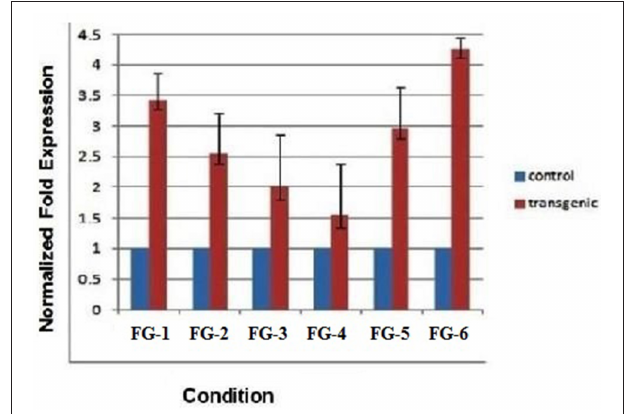
FIGURE 5 | Quantitative real time PCR to determine the expression of transgenic cotton plants (Fiber Gene GhEXPA8 ). Lines FG-8-1, FG-8-4, FG-8-5, FG-8-11, FG-8-13, and FG-8-15: described the different expression levels of transgenic and control mRNA samples, blue color represent the expression level of control plant samples (mRNA of untransformed cotton), red color indicated the mRNA expression level of putative transgenic lanes, GAPDH was used as an internal control for